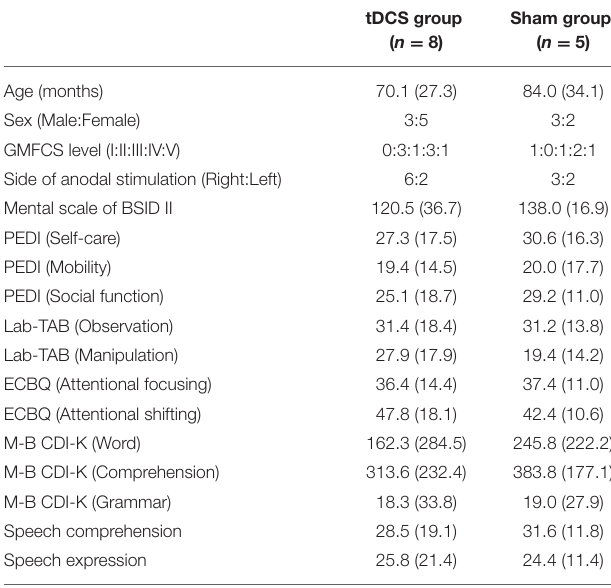
TABLE 1 | Comparison of baseline characteristics between the tDCS and sham